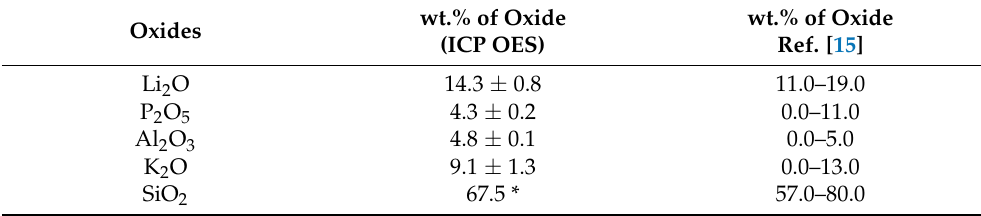
Table 2. Chemical composition of IPS e.max ® CAD measured by ICP OES and according to the